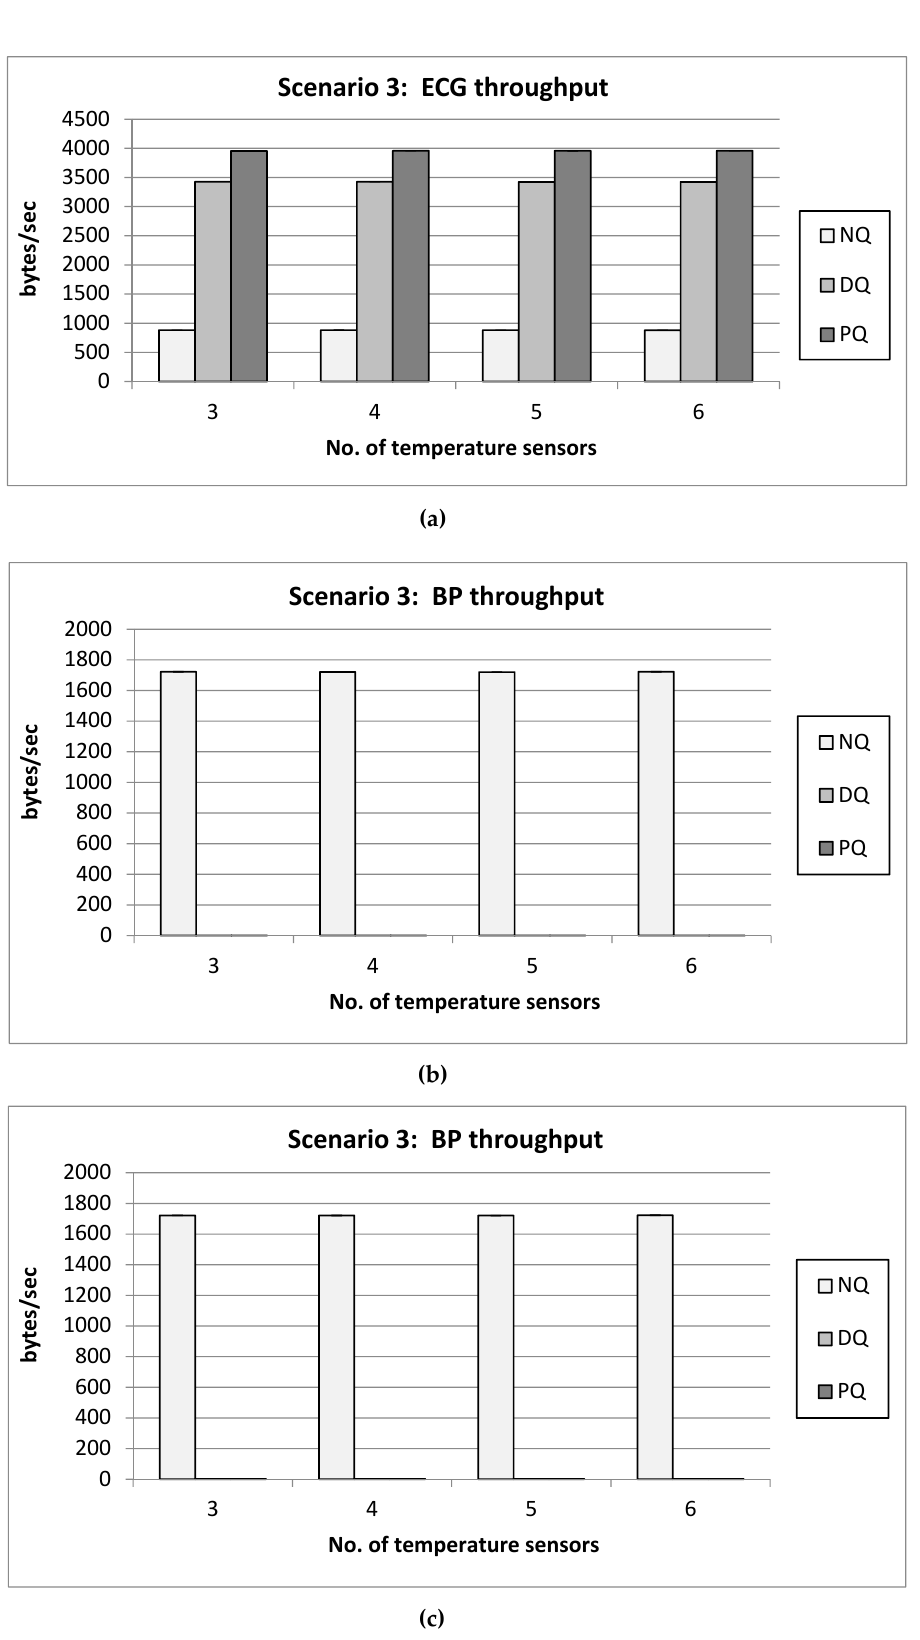
Figure 11. Average throughput results comparison for various data traffic types .